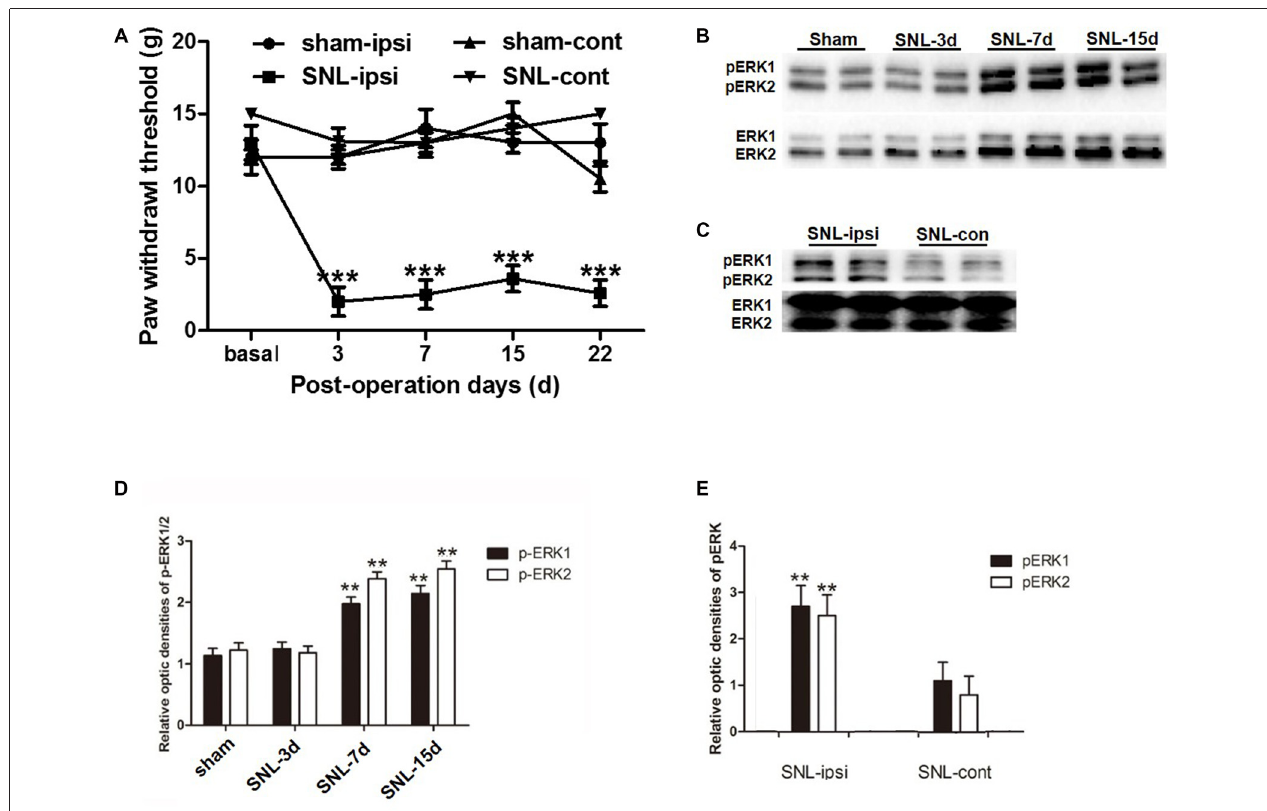
FIGURE 3 | The up-regulation of phosphorylated extracellular regulated protein kinases 1/2 (pERK1/2) within the spinal dorsal horn after SNL. SNL induced long-lasting ipsilateral mechanical hypersensitivity instead of contralateral hypersensitivity (A) . ∗∗∗ P < 0.001 compared with sham group. n = 6 in each group. Western blot analyses showed that SNL enhanced the level of spinal pERK1/2 from post-operation days (POD) 3 to POD 15 (B,D) . ∗∗ P < 0.01 compared with sham group. The pERK1/2 in the SNL model was primarily expressed in the ipsilateral spinal dorsal horn instead of the contralateral part on POD 15 (C,E) . ∗∗ P < 0.01 compared with the contralateral side. Duplication was introduced in the western blot analyses for accuracy judgment. n = 4 in each